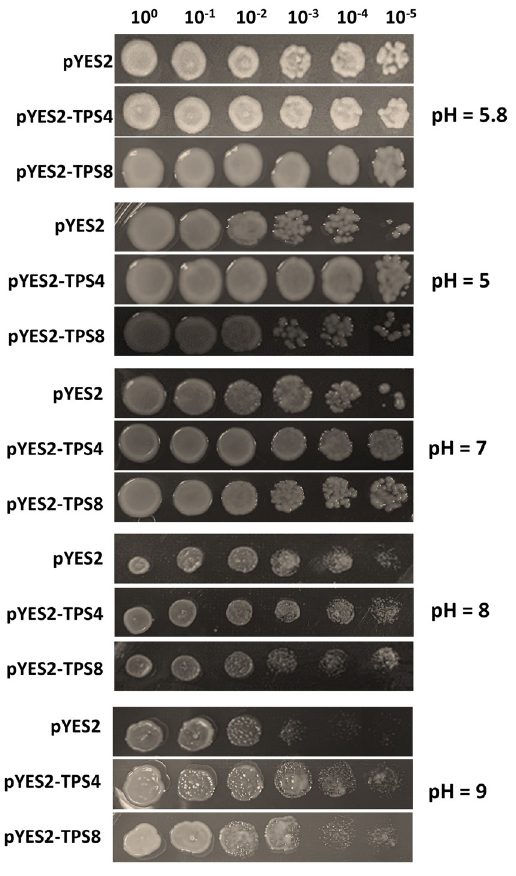
Figure 6. The growth activity of CqTPS4- and CqTPS8 -expressing yeast under saline-alkali stress. Yeast strain INVSC1 was transformed with the pYES2-CqTPS4, pYES2-CqTPS8, or pYES2 empty vector (control), respectively, and grew for 24 hrs on SC-Ura medium containing 25 mM NaHCO 3 with pH value as indicated. pH 5.8 was the control pH value.